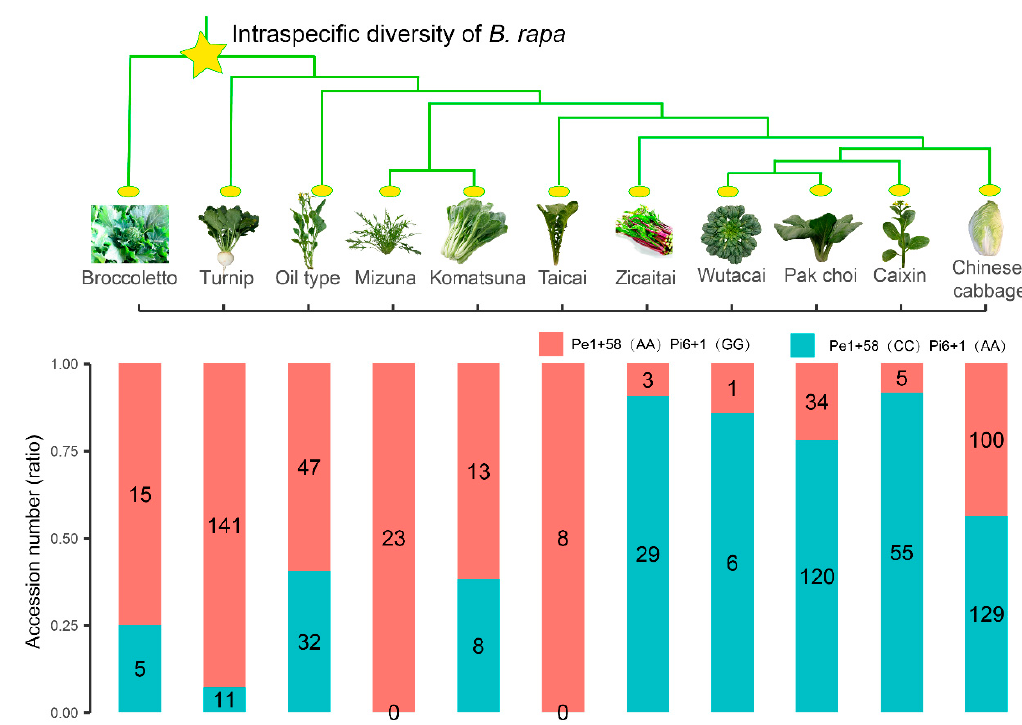
Figure 4. The frequencies of BrFLC1 haplotypes in a germplasm collection with 829 B. rapa accessions. The phylogenetic tree was constructed based on the neighbor joining tree constructed with resequencing data of 524 accessions [23]